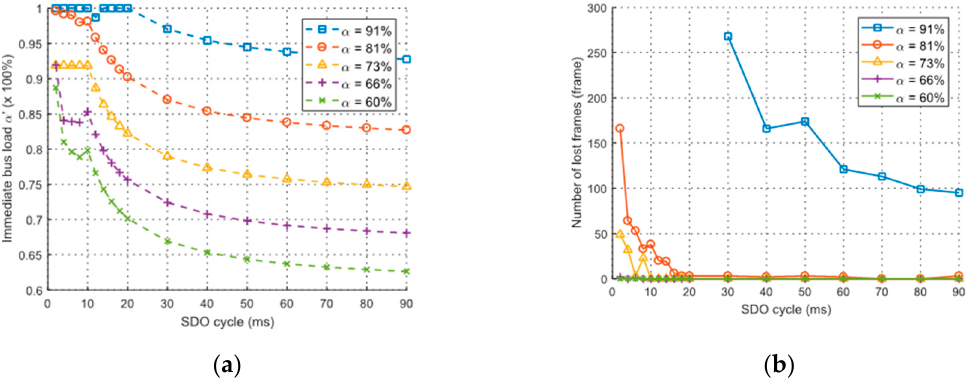
Figure 15. The e ff ect of the gateway’s SDO services. ( a ) E ff ect on CAN bus load, ( b ) e ff ect on frame loss. Figure 15. The effect of the gateway’s SDO services. ( a ) Effect on CAN bus load, ( b ) effect on frame loss.